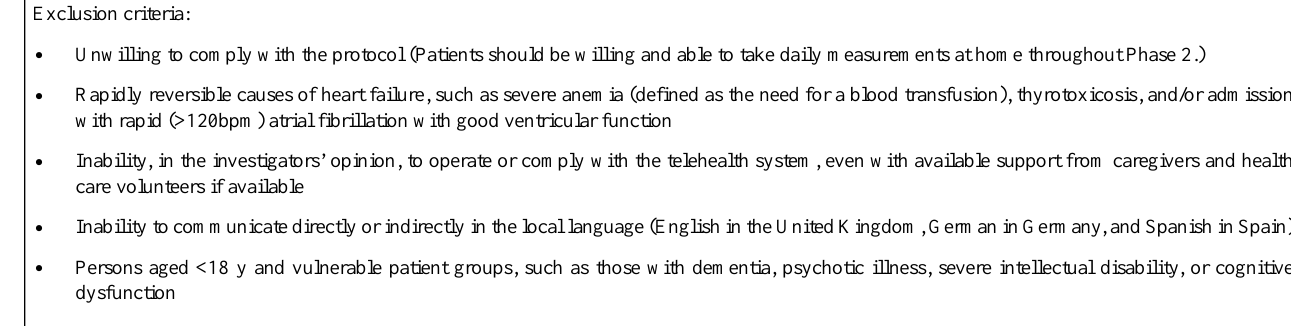
Textbox 2. Exclusion criteria for the HeartCycle